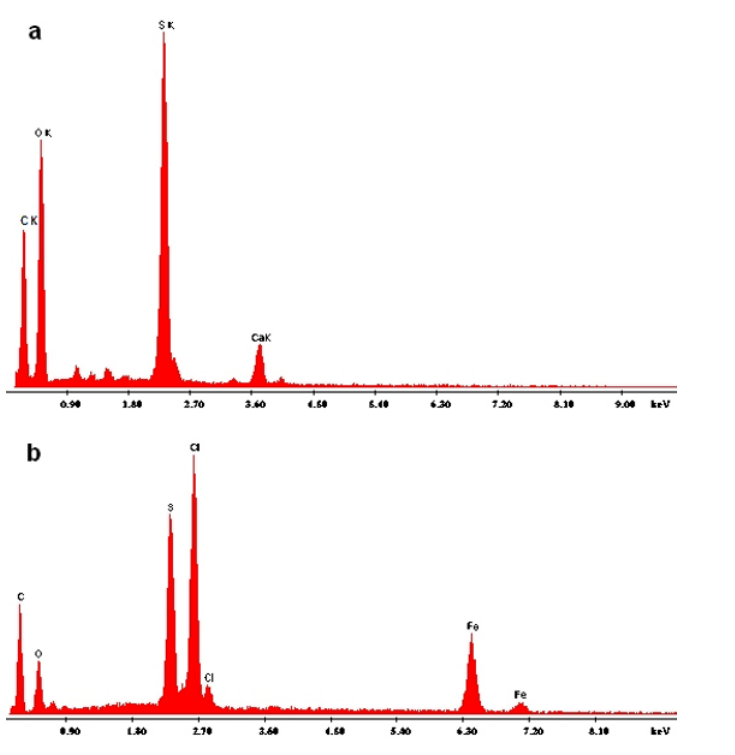
Figure 2. EDAX images of: a) sPEEK membrane, b) sPEEK/PANi composite membrane.